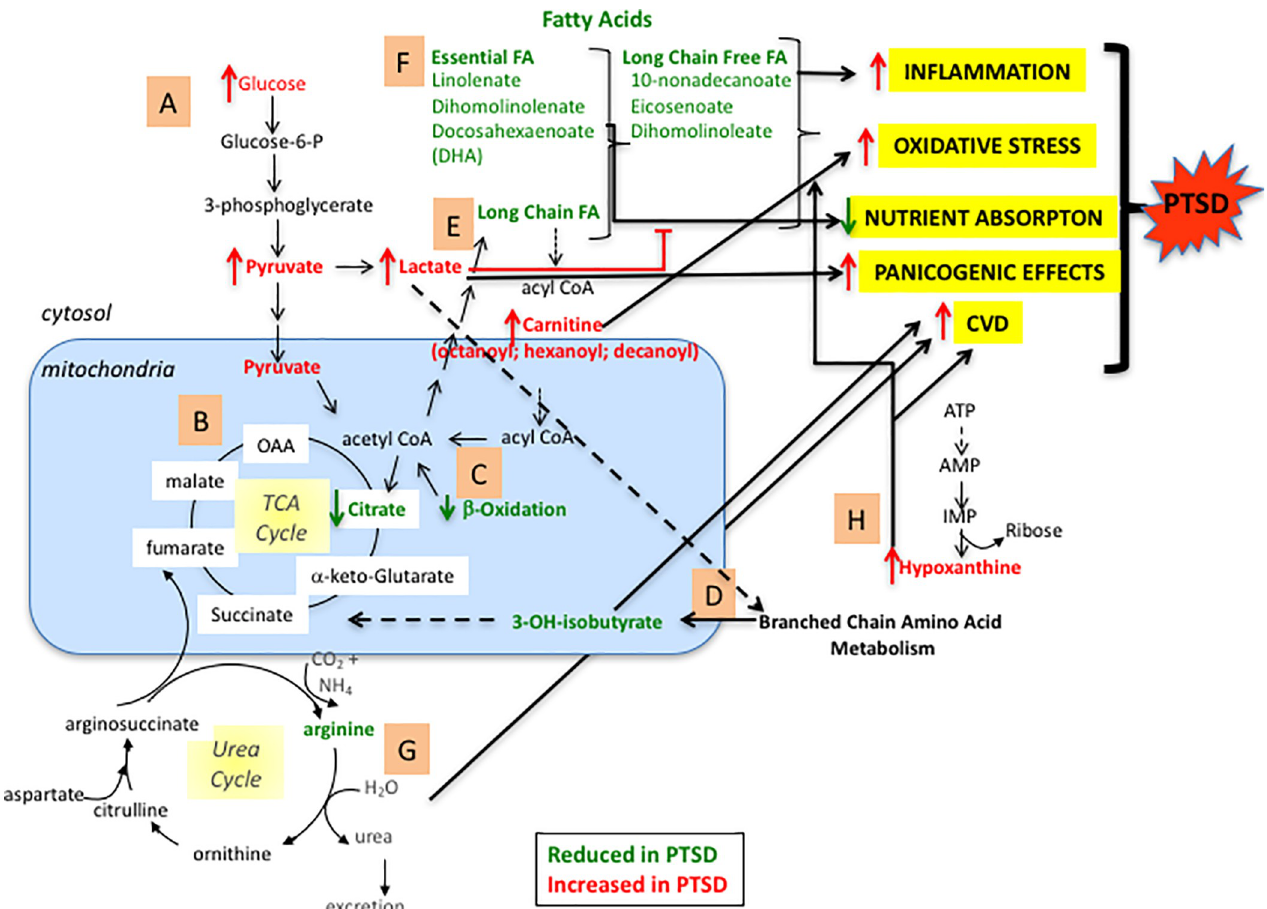
Fig 1. An overview of the metabolic imbalances in combat veterans with PTSD. The most significant metabolic alterations in PTSD can be organized into different biochemical pathways, including ( A ) glycolysis. ( B ) TCA cycle. ( C ) fatty acid oxidation, ( D ) branched chain amino acid pools, ( E ) lipid biosynthesis, ( F ) essential fatty acids, ( G ) urea cycle and ( H ) purine metabolisms. Metabolites that were elevated in PTSD in comparison to combat veterans who did not have PTSD are in red font, while metabolites that are reduced are in green font. Mitochondrial events are boxed in blue. Salient metabolic consequences that can potentially contribute to the manifestations of PTSD are highlighted in yellow, as discussed in the text.